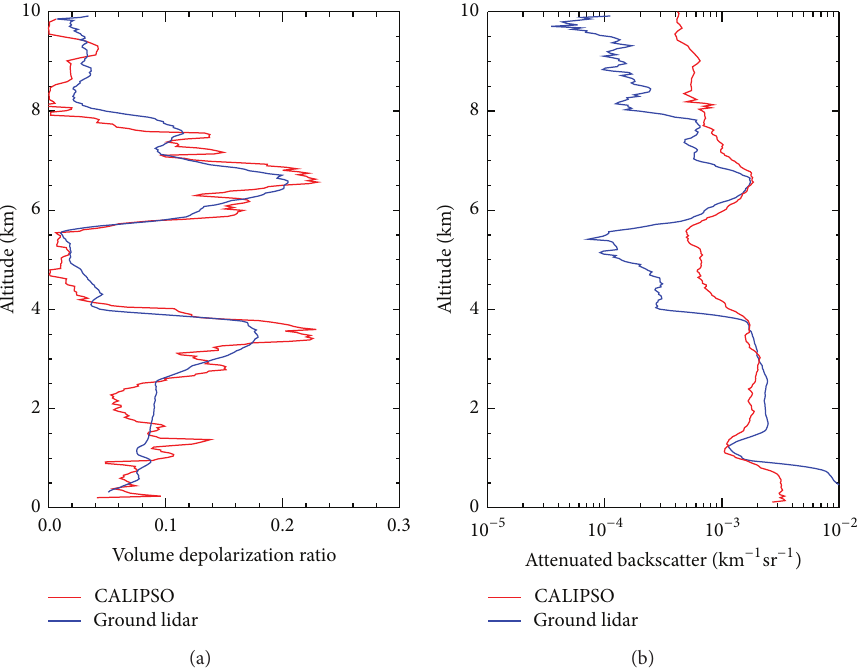
Figure 1: Comparison of the 532 nm (a) volume depolarization ratio profiles and (b) attenuated backscatter coefficient obtained by the depolarization lidar (blue curve) and simultaneous and nearly colocated CALIPSO measurements (red curve). The polarization lidar profile represents a 1min integration from 02:24 to 02:25 LST on 23 April 2011, while the CALIPSO profile stands for a ∼ 1s integration where the horizontal distances between the satellite footprint and our lidar site were less than 50